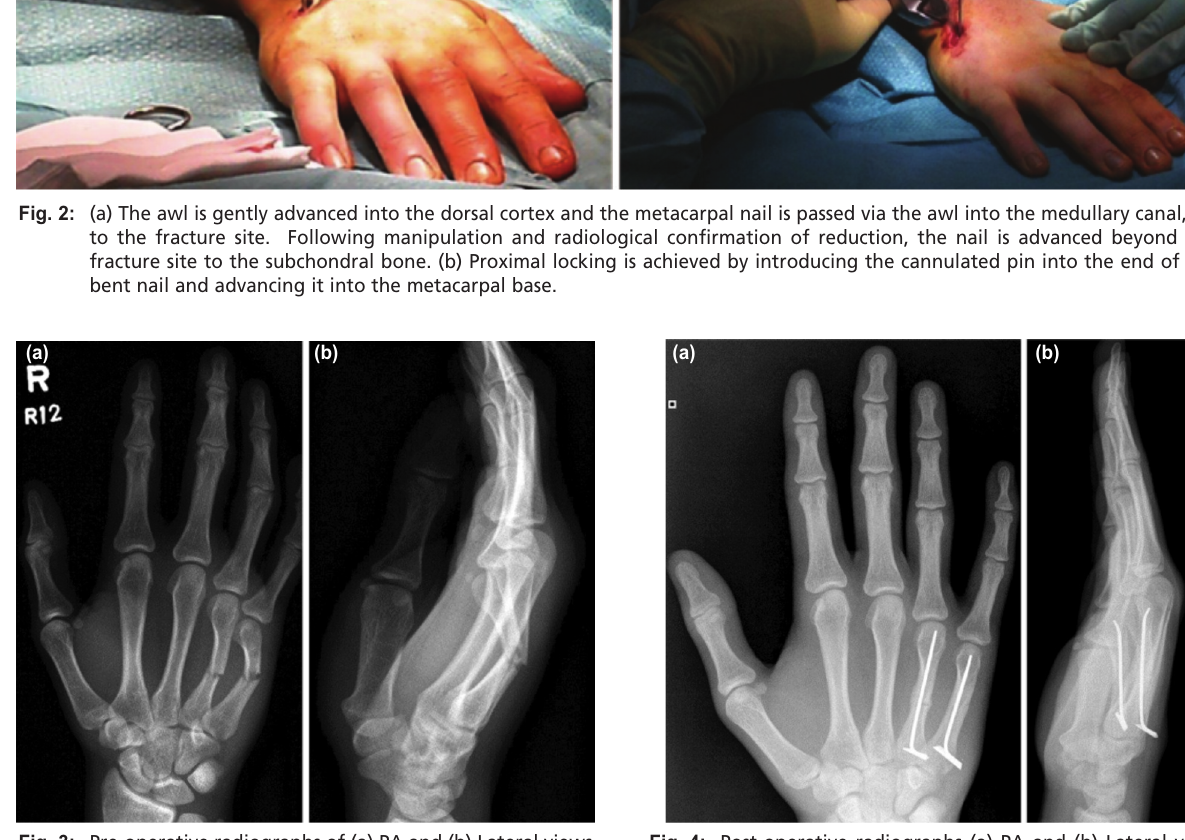
Pre-operative radiographs of (a) PA and (b) Lateral views Fig. 3: of transverse mid metacarpal ring and little finger shaft fractures.